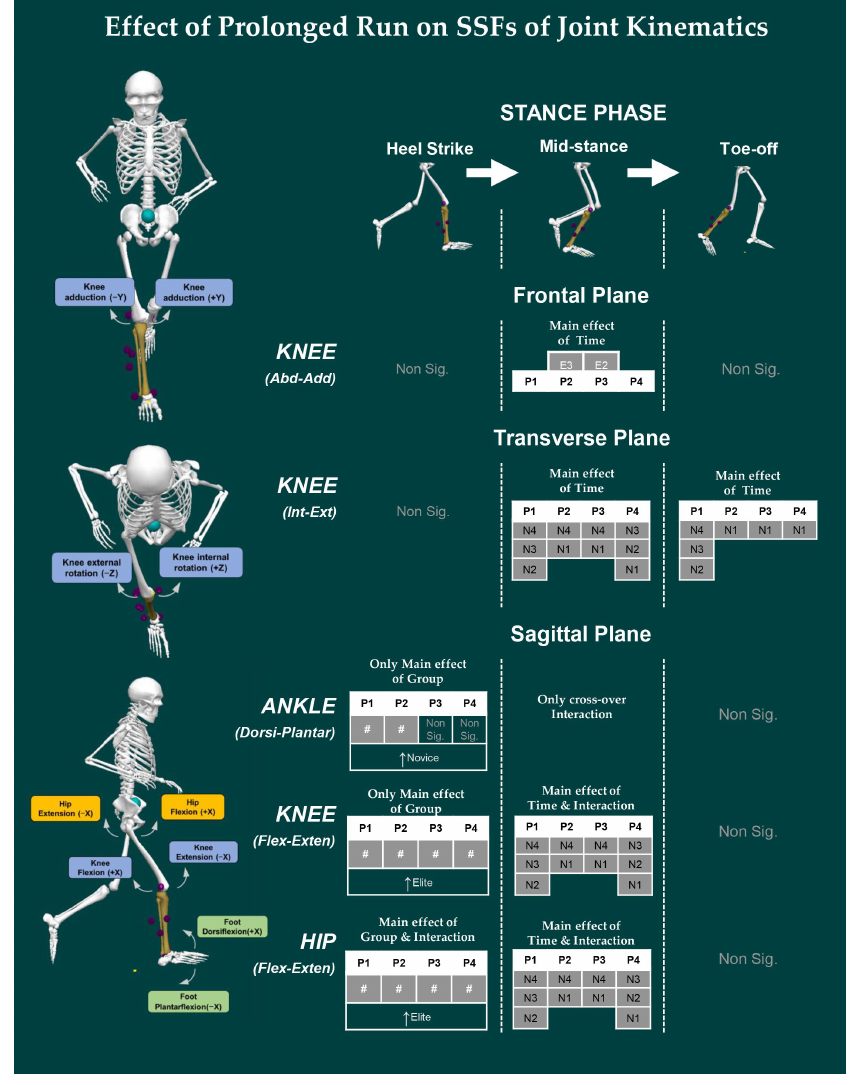
Figure 2. The change in SSFs for joint angles of lower extremity between novice and elite runners throughout the prolonged run is presented here. Note: Only results with significant differences are labeled in the skeleton. “Stride-to-stride fluctuation” denoted as: “SSF” and “stride-to-stride variation” denoted as “SSV”, The main effect of Group and Interaction represented by “#”. The main effect of Time and Interaction for each time interval for each group (E = Elite; N = Novice), for example, the difference in time interval in P1 vs. P2 for novices is denoted as N1 vs. N2. Non- significant differences are represented by “Non sig.” For details, see Appendix B. The skeleton used for figure was created using Visual 3D